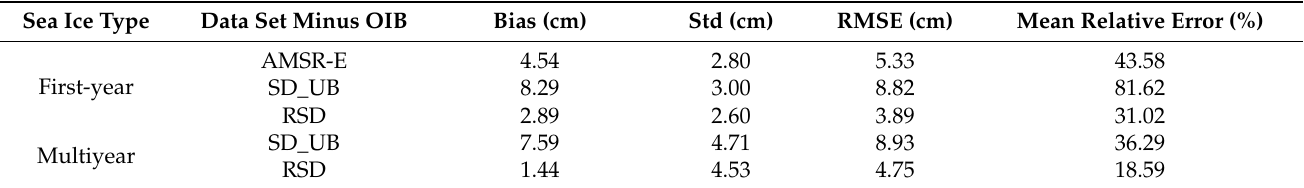
Table 9. Algorithm verification results.